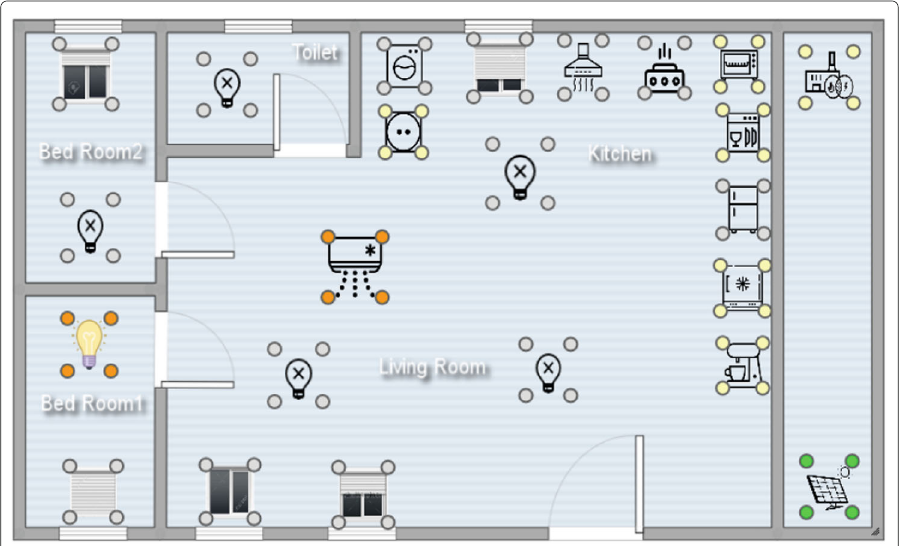
Fig. 16 BOS UI: devices overview based on a floor